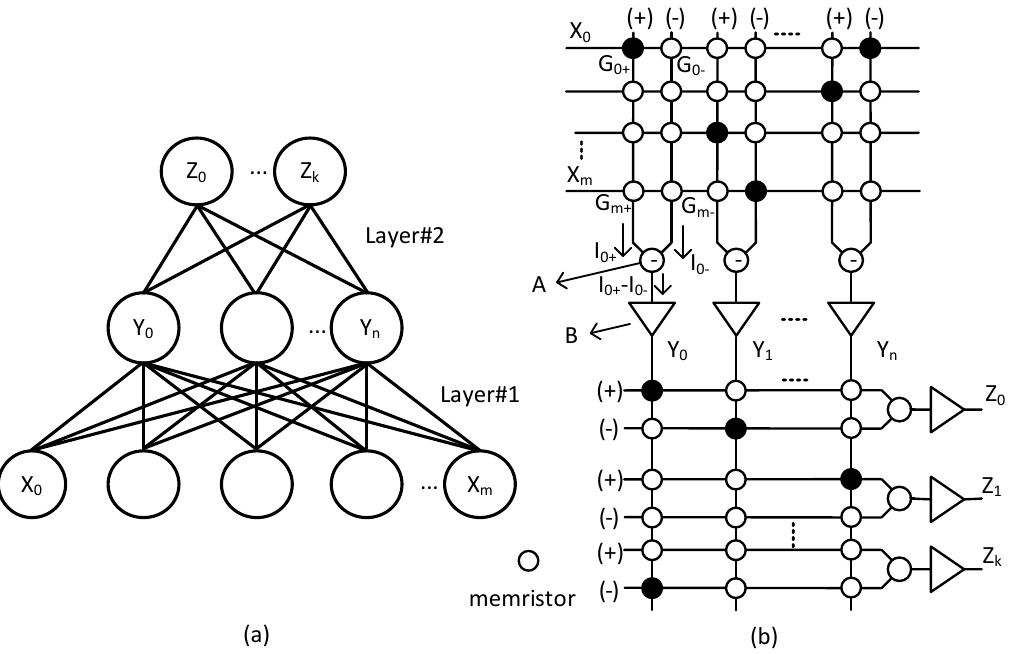
Figure 1. ( a ) The block diagram of artificial neural networks with input, hidden, and output neurons ( b ) The memristor crossbars for implementing the neural networks.